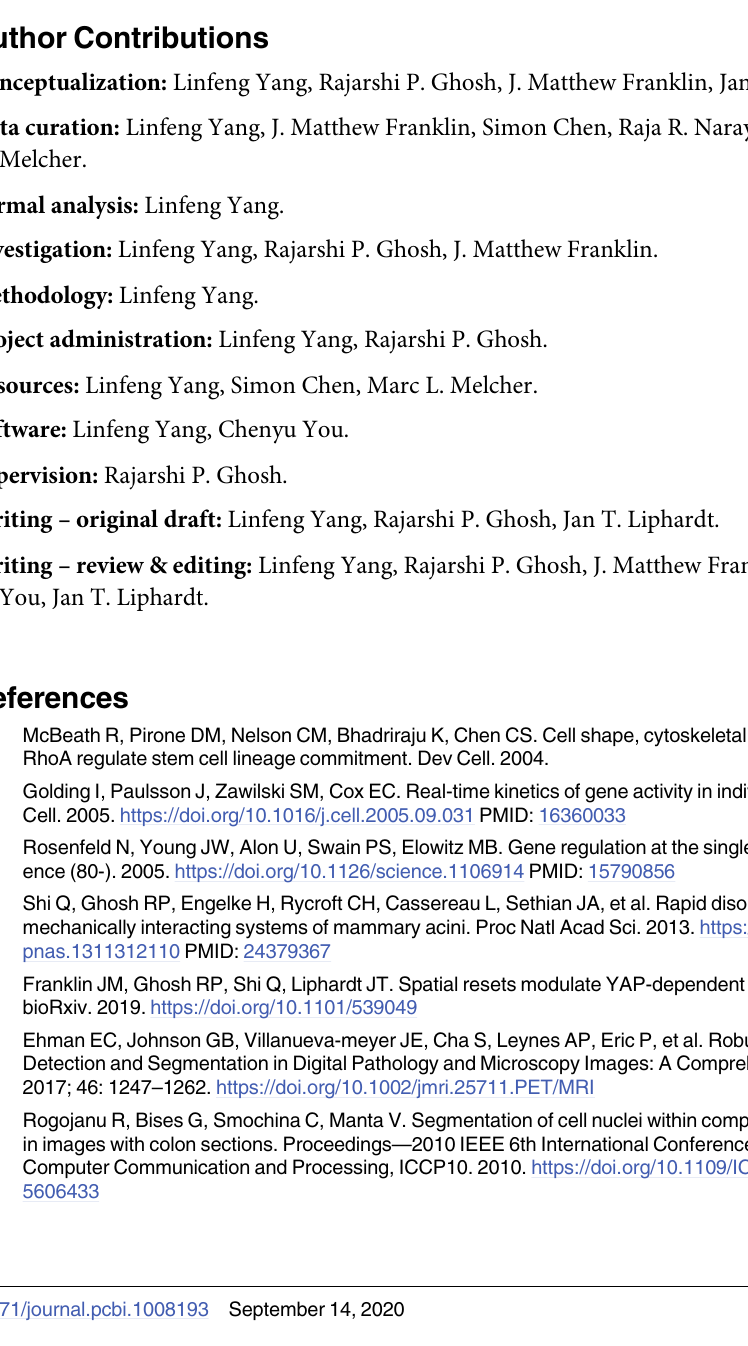
S6 Fig. Additional examples showing NuSeT’s performance when handling images with signal variations, shape variations, touching nuclei and sample preparation artifacts. S7 Fig. Additional fluorescent mitotic events detection and segmentation